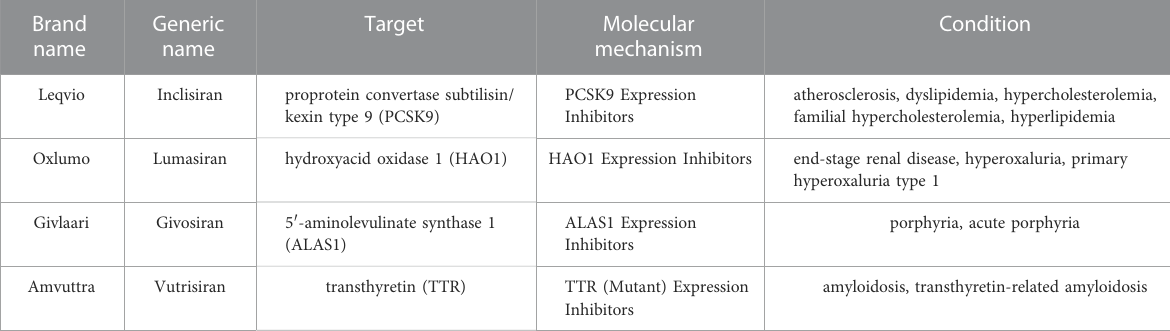
TABLE 1 Marketed GalNAc-conjugated RNA drugs.